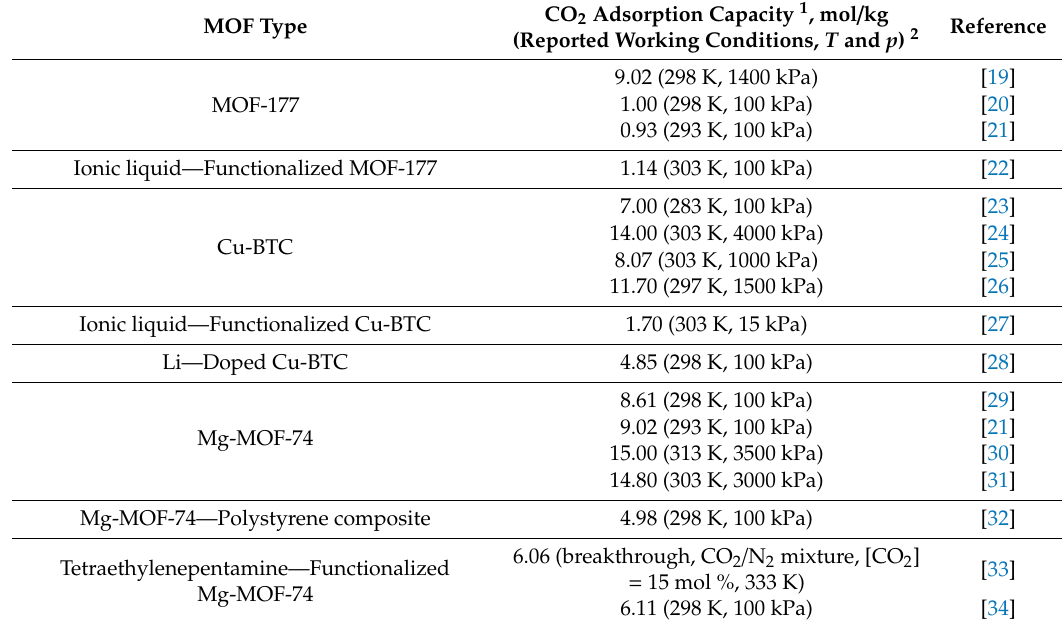
Table 1. Metal–organic frameworks (MOFs) potentially suitable for CO 2